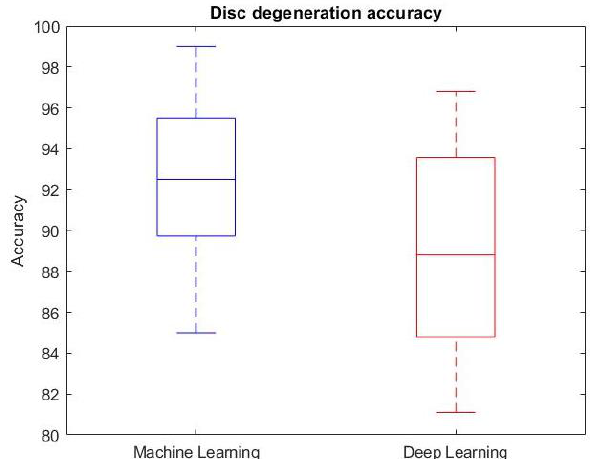
Figure 4. Accuracy of the LBP diagnosis task of studies using different features, reported on the vertical axis, and both deep learning (red asterisks), machine learning (blue circles) or both (black square) approaches.